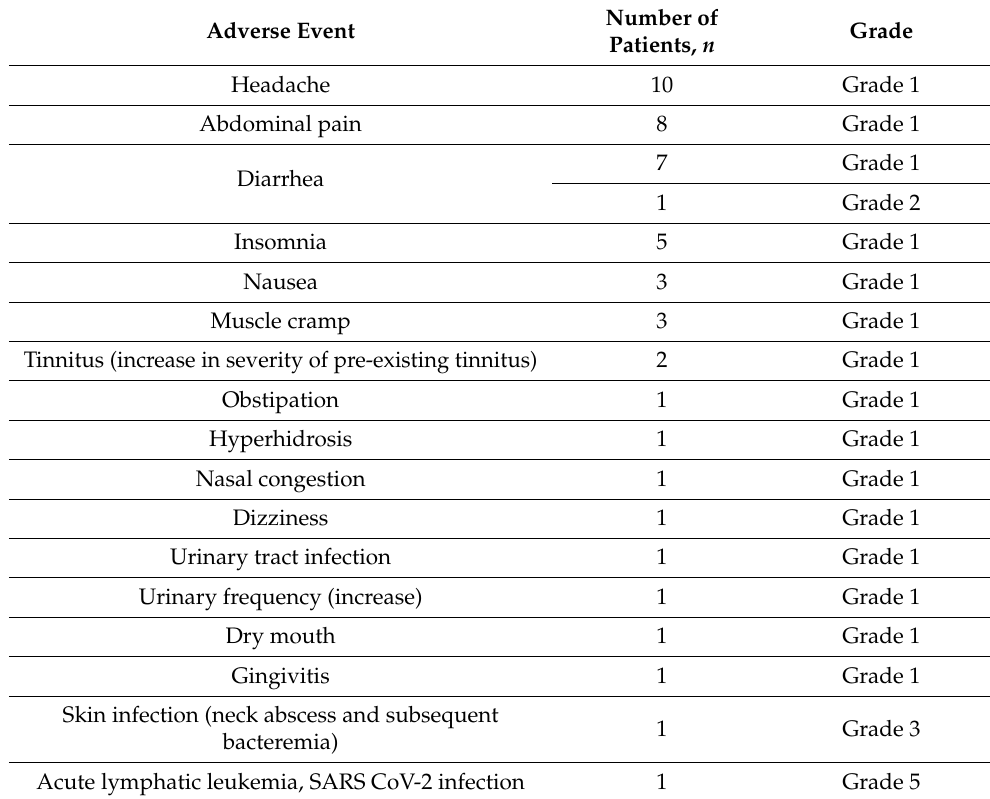
Table 2. Adverse events according to the Common Terminology Criteria for Adverse Events (CTCAE) version